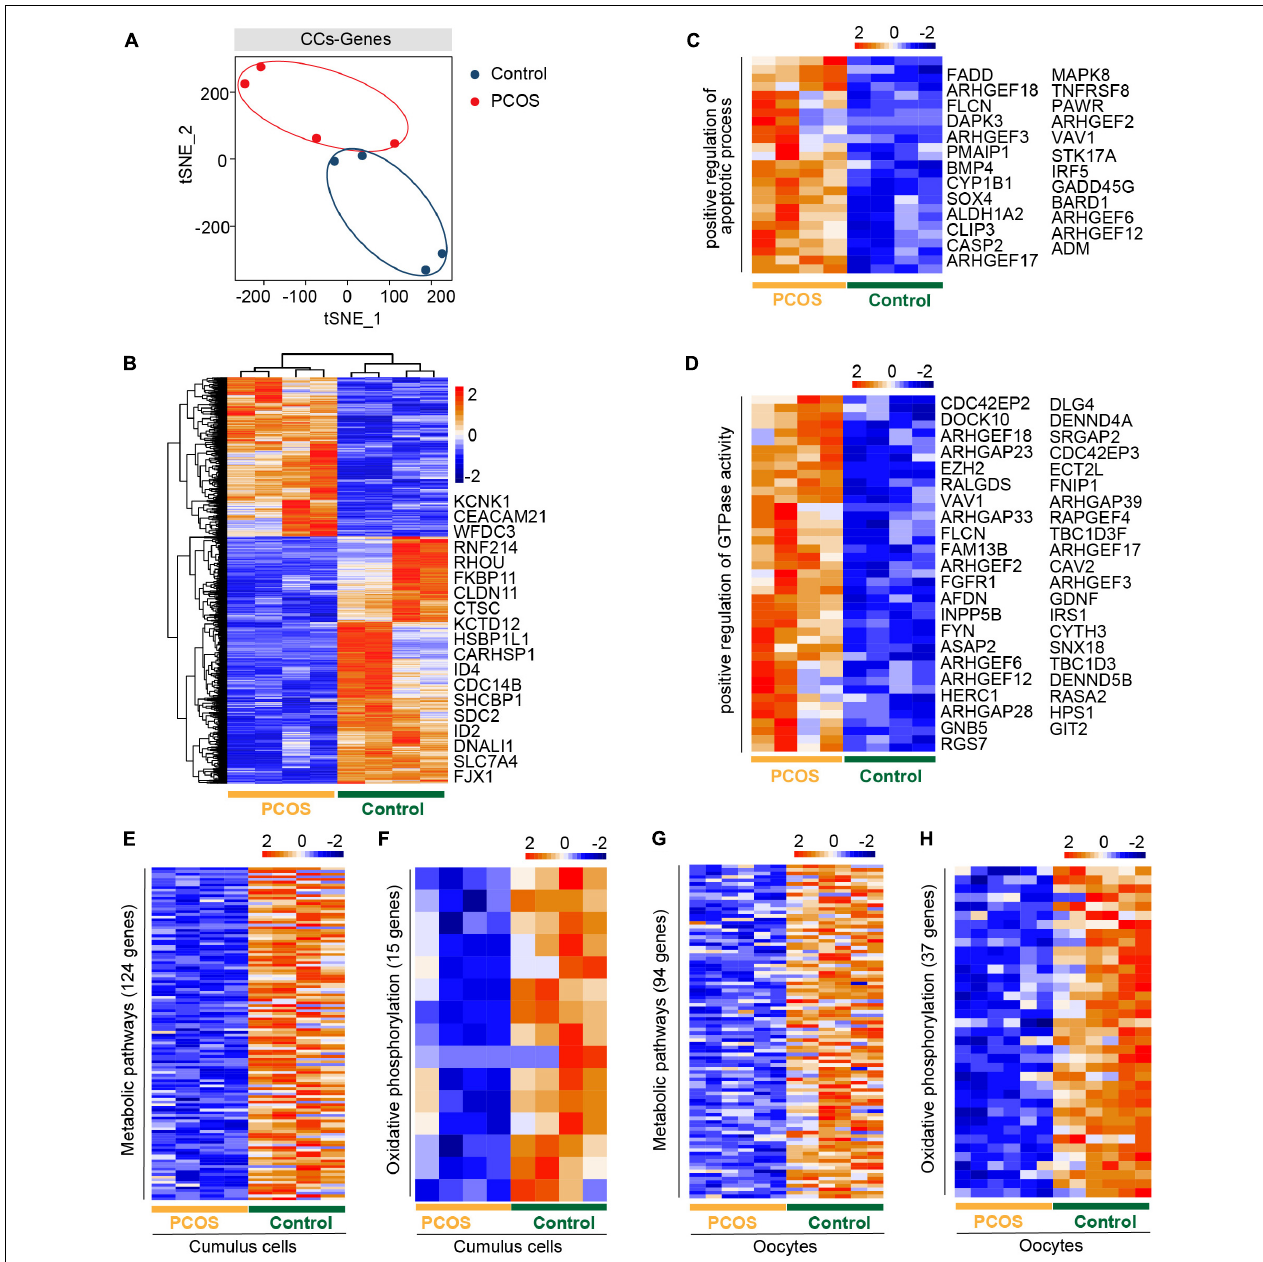
FIGURE 2 | The gene expression pattern differs between PCOS and control cumulus cells (CCs). (A) Visualization of gene expression by RNA-seq from four CC samples by t-SNE, showing that CCs are clustered into two distinct subpopulations. The red and blue points represent PCOS and control CCs, respectively. (B) Heat map of DEGs in CCs between PCOS and control. The number of up-DEGs is 704 and down-DEGs is 1,091. The color key from blue to red indicates the relative gene expression levels from low to high, respectively. (C) Heatmap of genes involved in the positive regulation of apoptotic process upregulated in PCOS CCs. (D) Heat map of genes related to the positive regulation of GTPase activity upregulated in PCOS CCs. (E) Heat map of genes involved in metabolic pathways downregulated in PCOS CCs. (F) Heat map of genes involved in oxidative phosphorylation downregulated in PCOS CCs. (G) Heat map of genes related to metabolic pathways downregulated in PCOS oocytes. (H) Heat map of genes related to oxidative phosphorylation downregulated in PCOS oocytes.